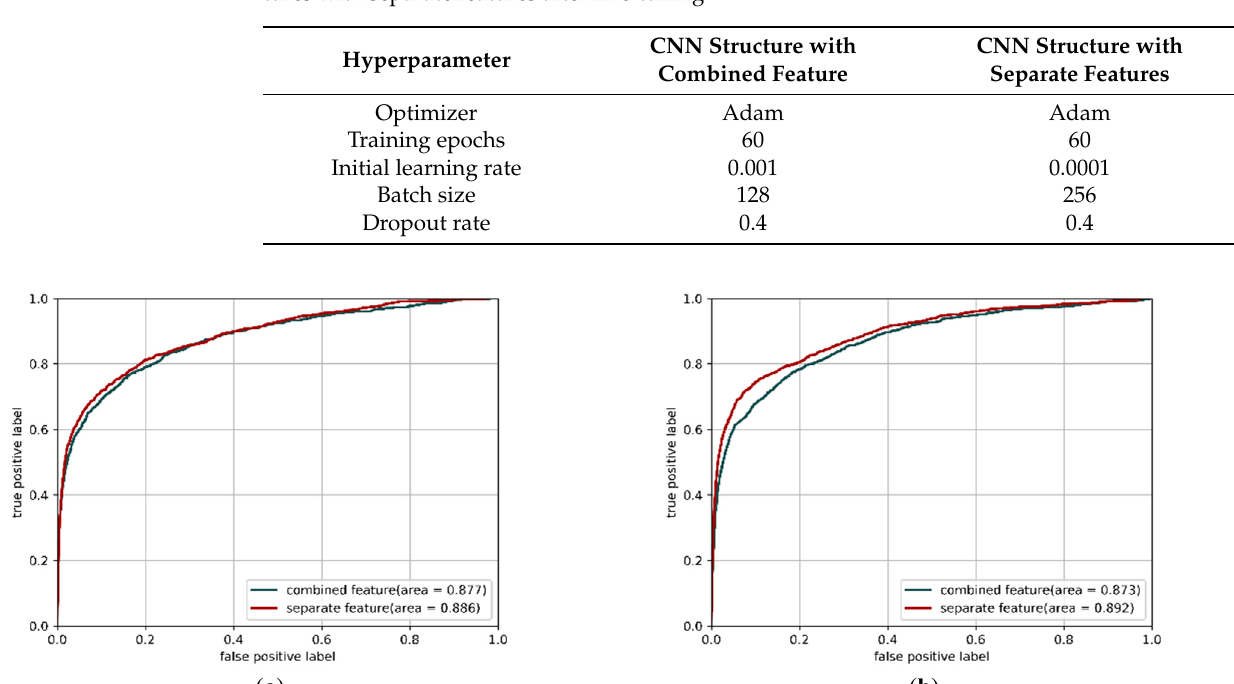
Figure 4. ROC curves of the multi-IncepResNet-based predictor ( a ) and the multi-Xception-based predictor ( b ) with combined features and separate features as the inputs. The corresponding AUC values are listed in the subfigure legends.